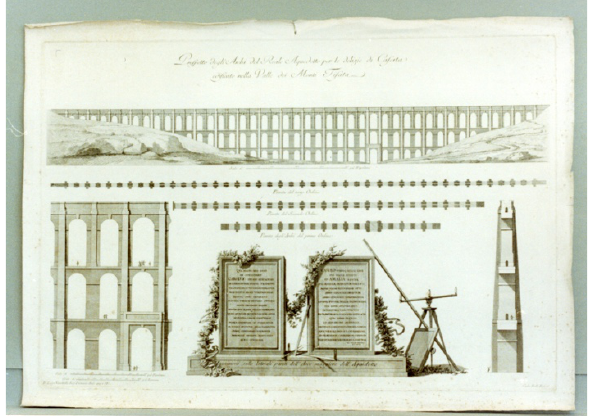
Figure 6 . Carlo Nolli, prospetto degli archi del